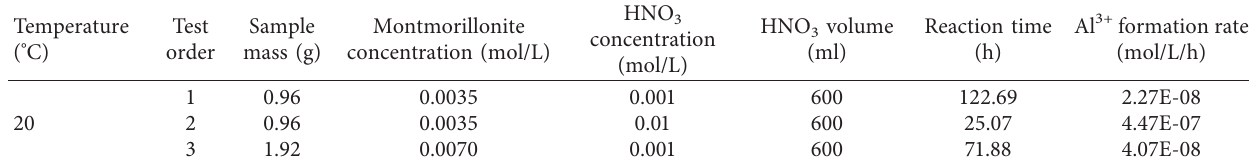
Table 2: Experimental data of the chemical reaction kinetics.